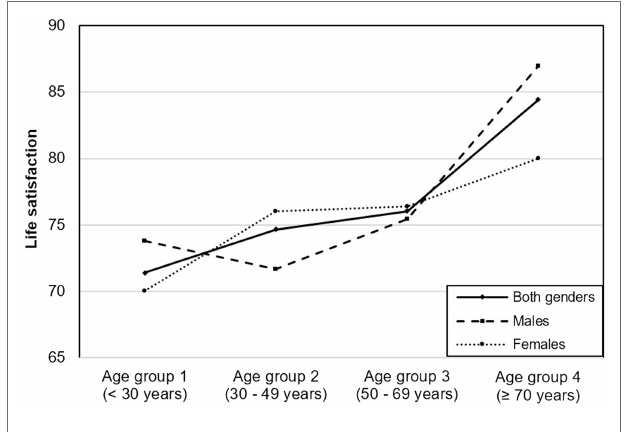
TABLE 6 | Linear regression model for the dependent variable life satisfaction and happiness, socio-demographic variables, and interactions of happiness with different age groups as independent variables.